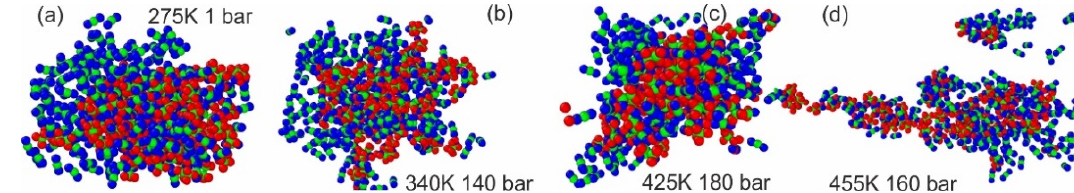
Figure 1. Visualization of the simulation results. Molecules of carbon, oxygen, and hydrogen are shown in green, blue, and red correspondingly. The figure shows the values of temperature and pressure. ( a ) Liquid ethanol with dissolved carbon dioxide with surrounding gaseous carbon dioxide; ( b ) the Widom delta of carbon dioxide; ( c ) the most compressed mixture with a uniform distribution of carbon dioxide and ethanol molecules; ( d ) the Widom delta of the mixture.